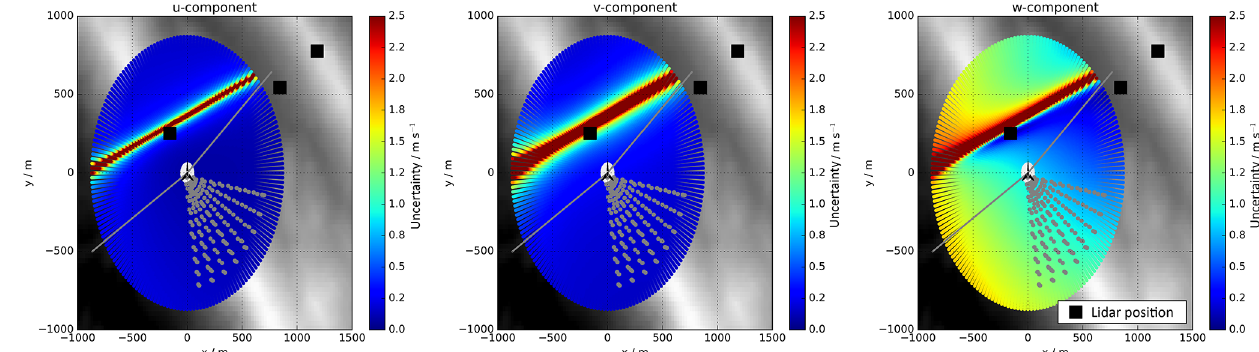
Figure 5. Map of uncertainties at hub height in a radius of 10 D around the wind turbine for the u , v and w component of the wind vector for a radial wind speed uncertainty (cid:15) = 0.1. The gray lines show the borders of the target sector for wake measurements; the gray dots show the actual measurement points during the two analyzed periods. In the background is the orography in gray